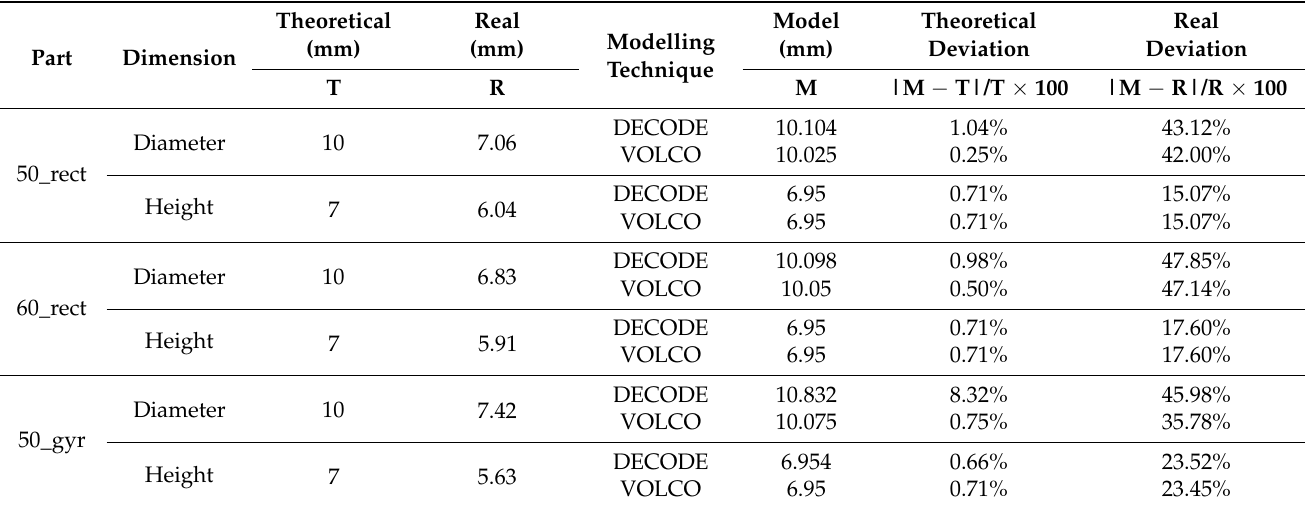
Table 10. Comparison of